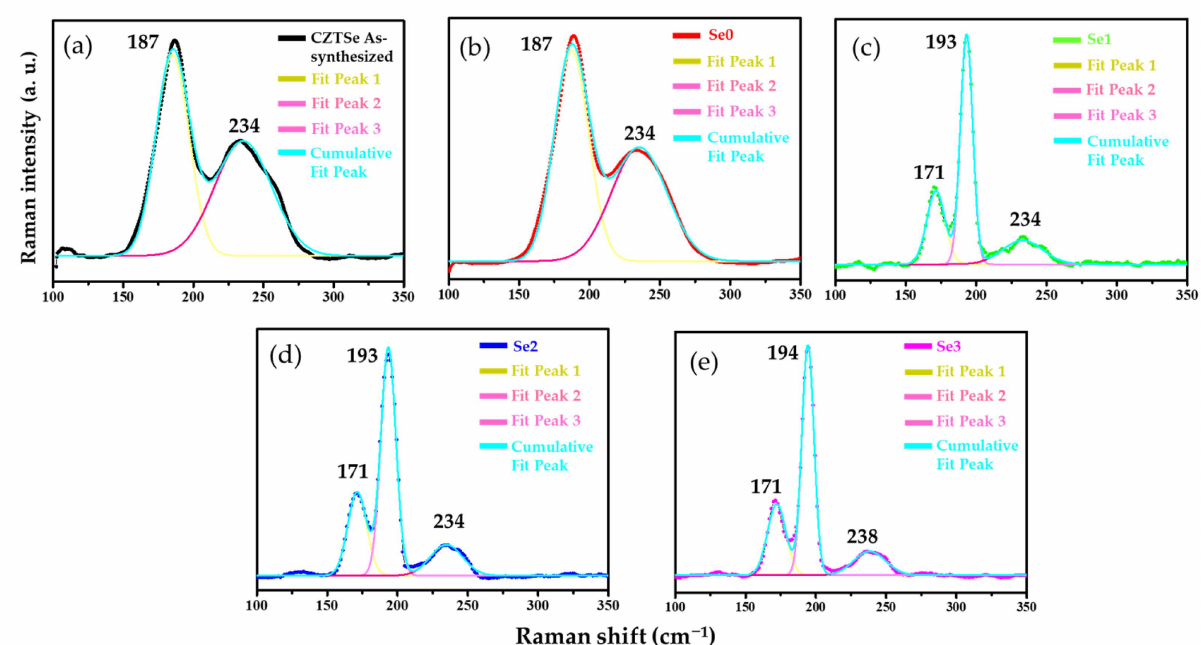
Figure 3. Raman Spectra of CZTSe thin films: ( a ) As-synthesized CZTSe NP, ( b ) as-deposited CZTSe thin film (Se0), ( c ) Se1 (annealed at 500 ◦ C), ( d ) Se2 (annealed at 520 ◦ C), and ( e ) Se3 (annealed at 550 ◦